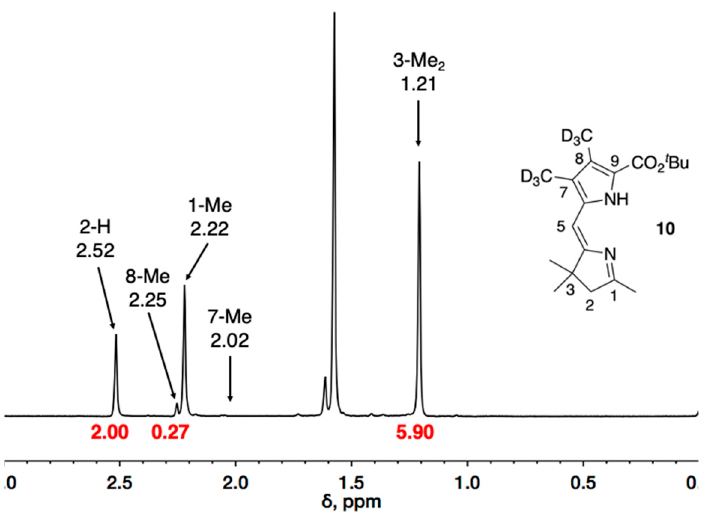
Figure 1. 1 H NMR spectrum of 10 showing effects of deuterium incorporation, with peak integrations at the bottom in red.